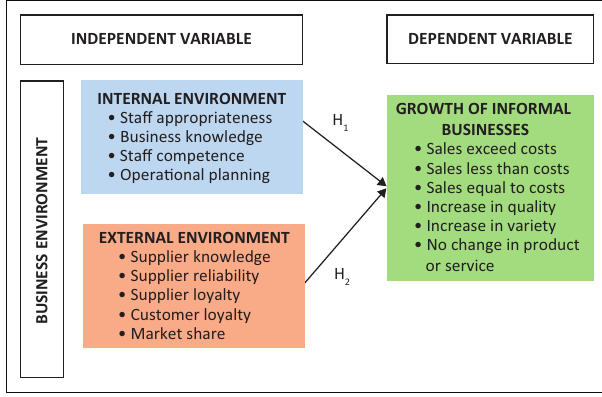
FIGURE 2: Validated framework used for empirical testing of the relationships between the business environments and growth of informal businesses.